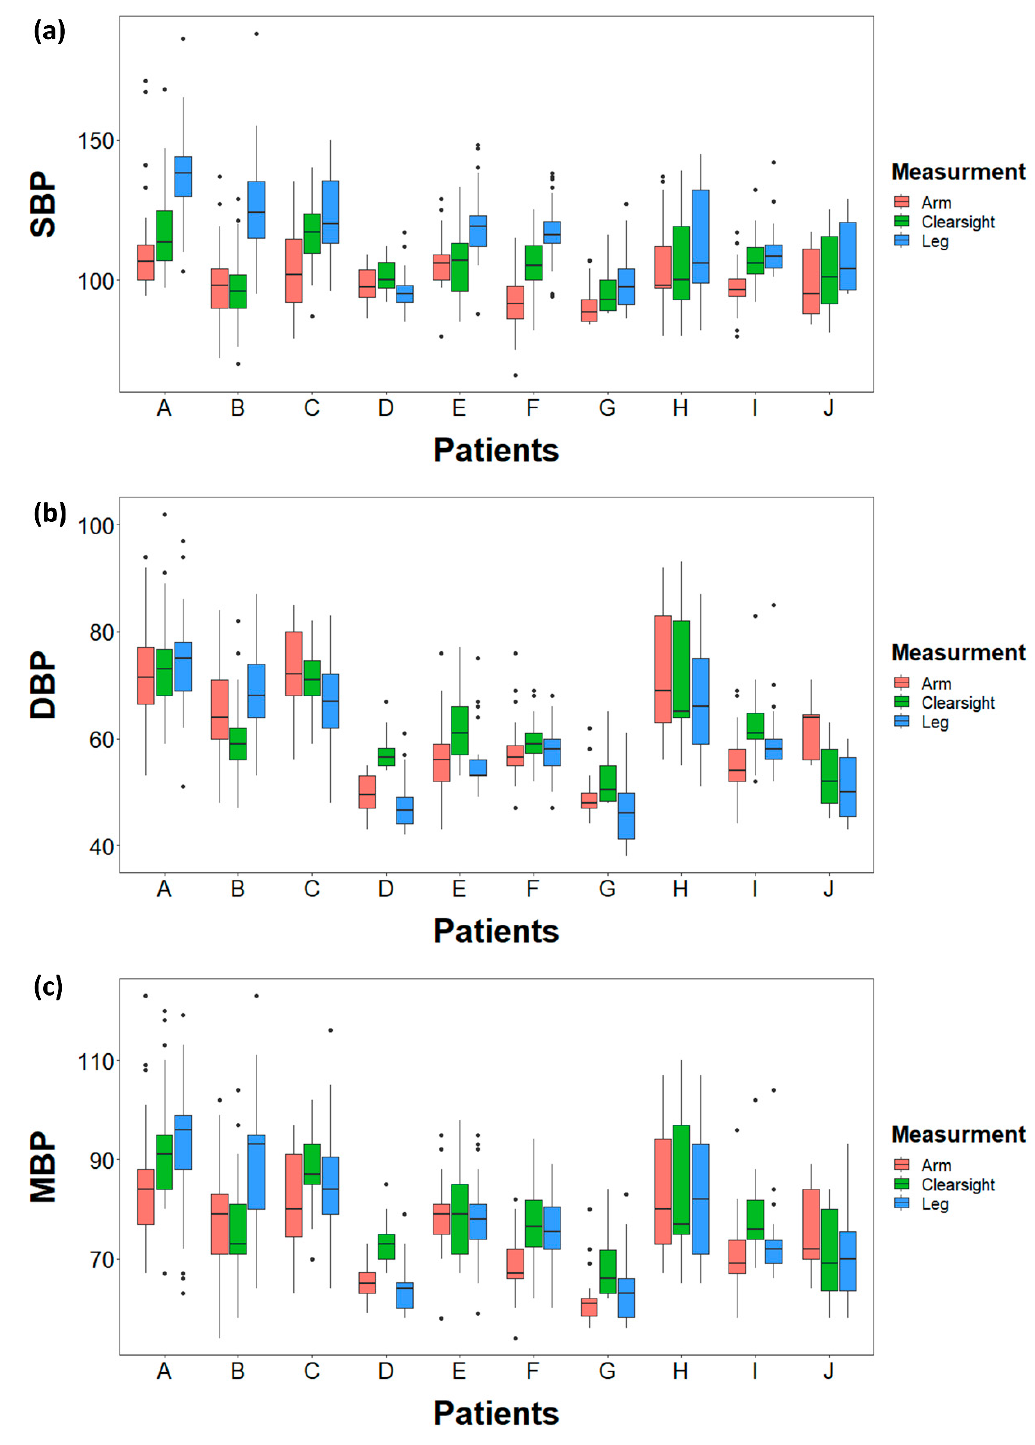
Figure 5. The boxplots of each individual patient showing distribution of ( a ) SBP, ( b ) DBP and ( c ) MBP measurements by each of three methods. The red boxes represent measurements from arm, the green boxes represent measurements from ClearSight and the blue boxes represent measurements from ankle.